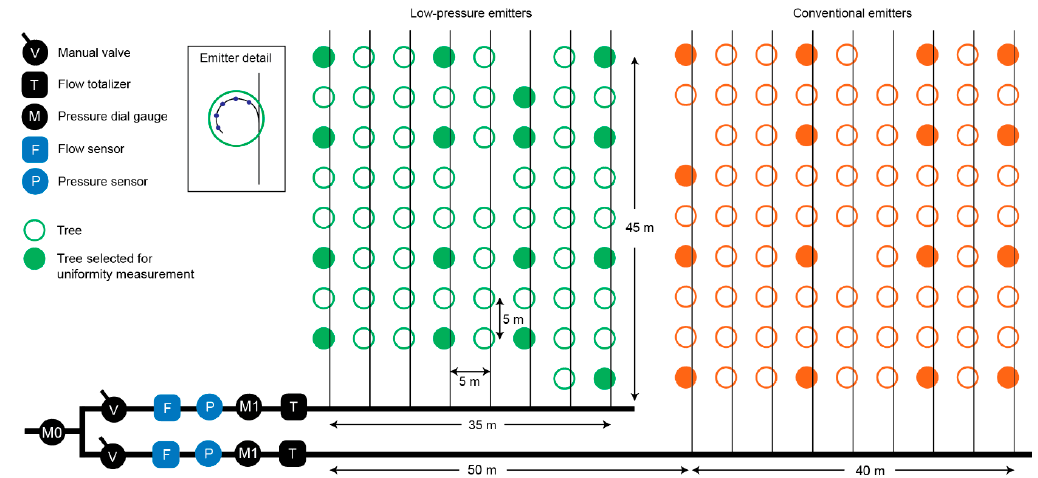
Figure 4. Diagram of a typical experimental site, featuring two plots with low-pressure emitters and conventional emitters as the control (site 6, Sharhabeel Citrus). Each circle represents one citrus tree; the filled-in circles are the 16 trees per plot selected for uniformity measurement. At each of these trees, the flow rates of two emitters were measured for a total of 32 emitters per plot, and the measured flow rates were used to calculate statistical uniformity of water application throughout the plot. The instrumentation section components are shown, including the valves used to set submain pressures, and pressure and flow measurement instruments.